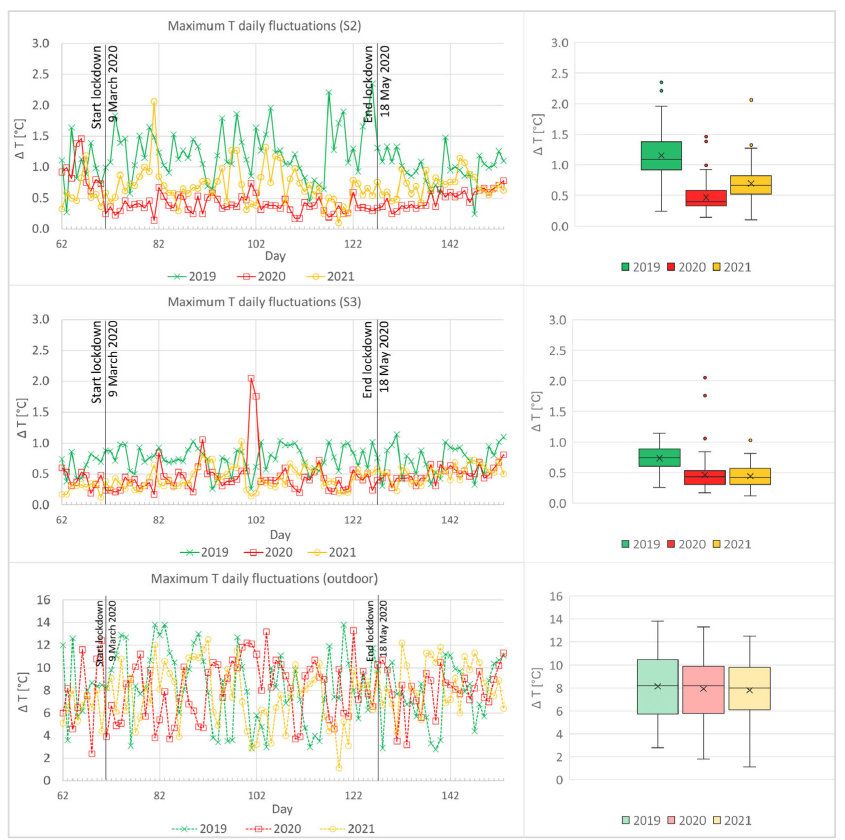
Figure 10. Maximum daily T fluctuation in the area close to the doors (S2), close to the organs (S3) and